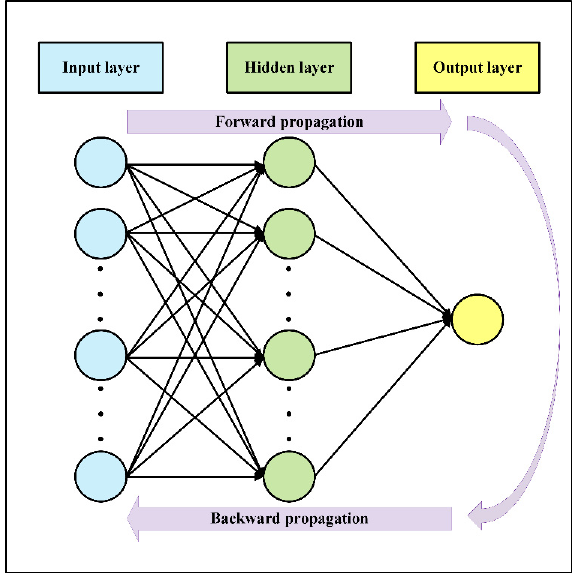
Figure 3. The sketch illustrates the overall architecture of a classification NN including the forward and backward propagation algorithm.